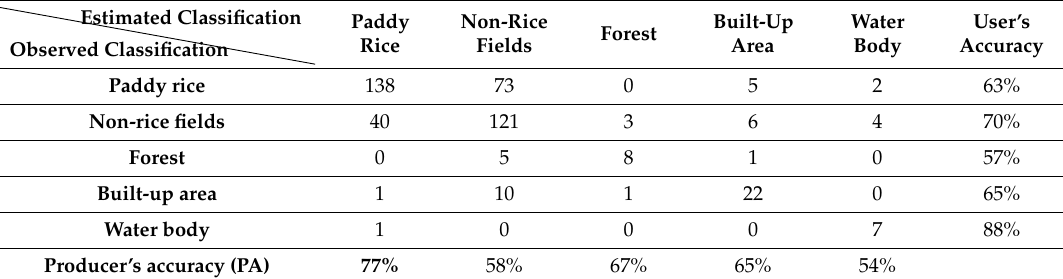
Table 4. Confusion table of the combination of VV and VH and EVI.